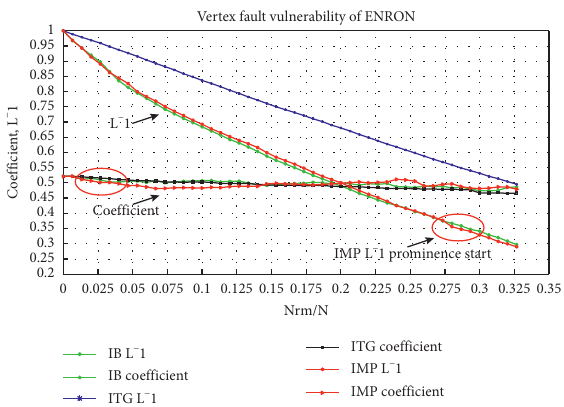
Figure 18: l − 1 $ C G �( V,E ) result of ENRON.